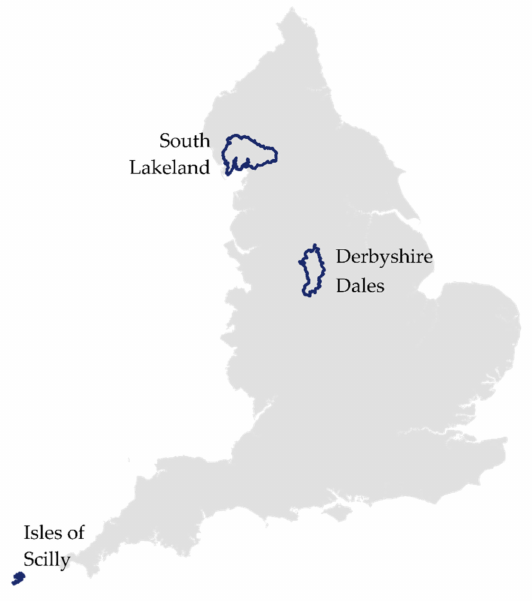
Figure 3. Local authority case studies in